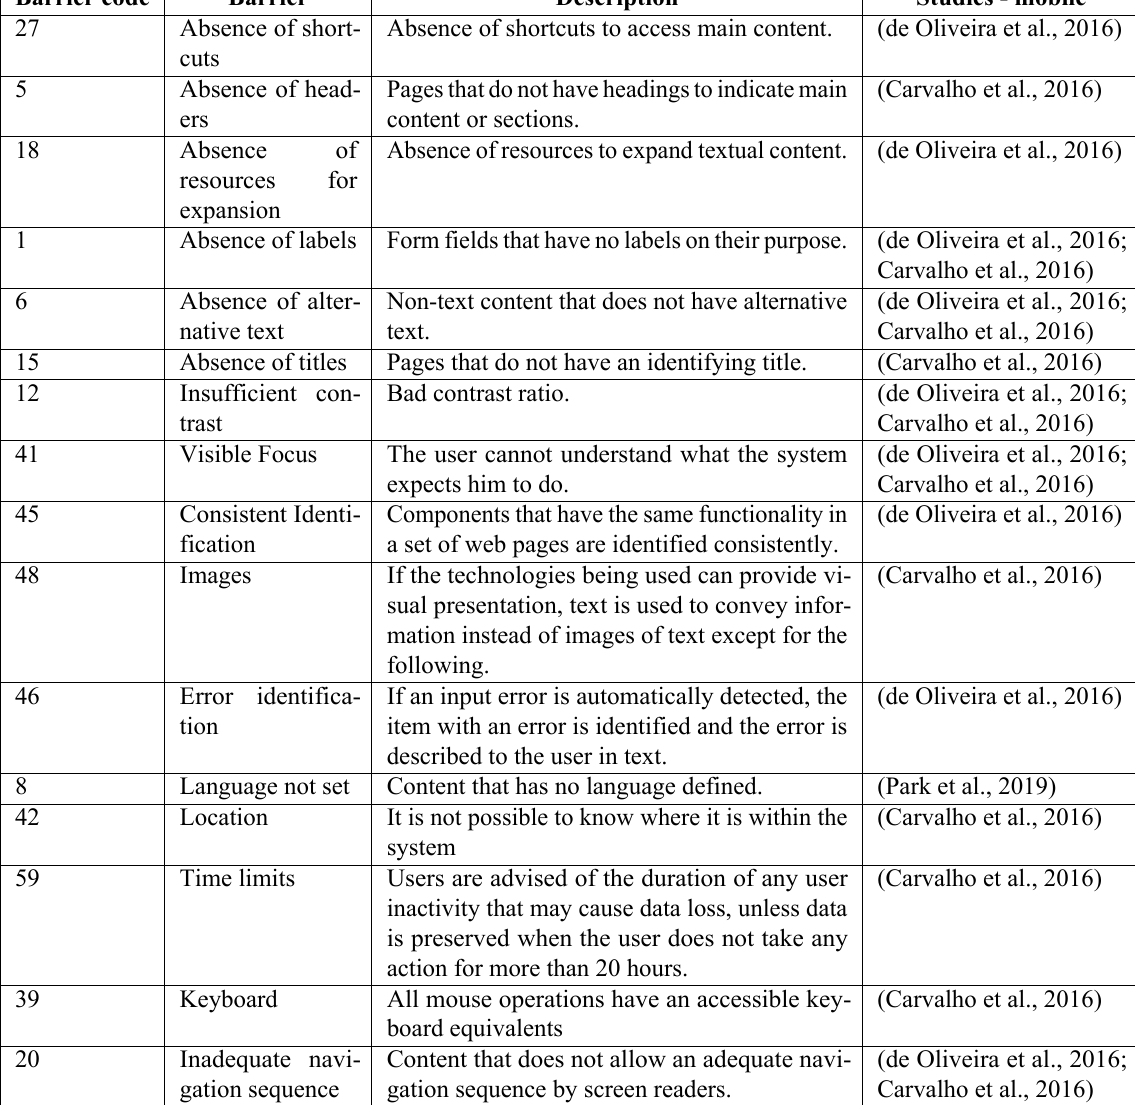
Table 13. Accessibility problems encountered by expert inspections on mobile